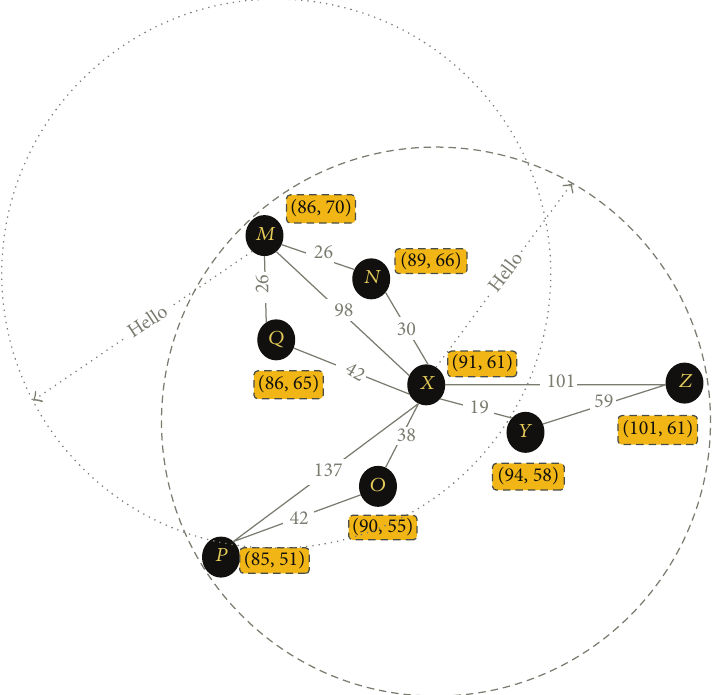
Figure 1: Nodes with location information.